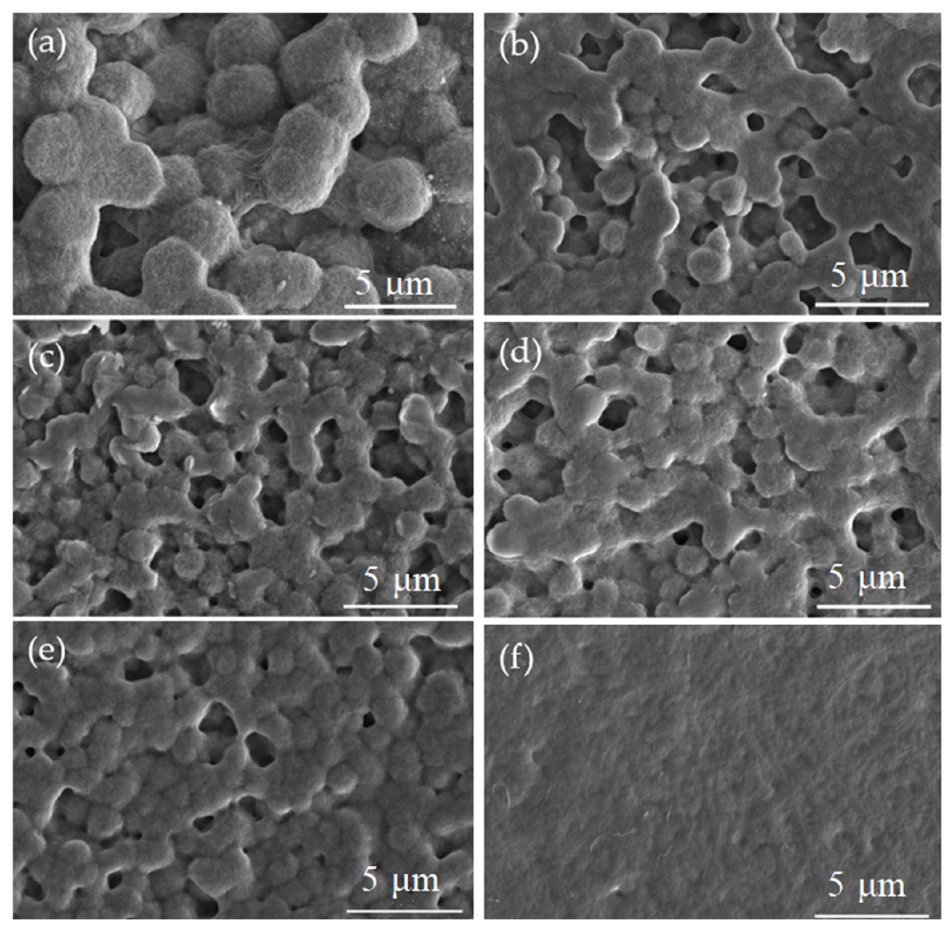
Figure 3. SEM surface topography of ( a ) pure PVDF film and PVDF/CaCl 2 composite films with ( b ) 0.05 wt.%, ( c ) 0.1 wt.%, ( d ) 0.15 wt.%, ( e ) 0.2 wt.%, and ( f ) 0.3 wt.% CaCl 2 .